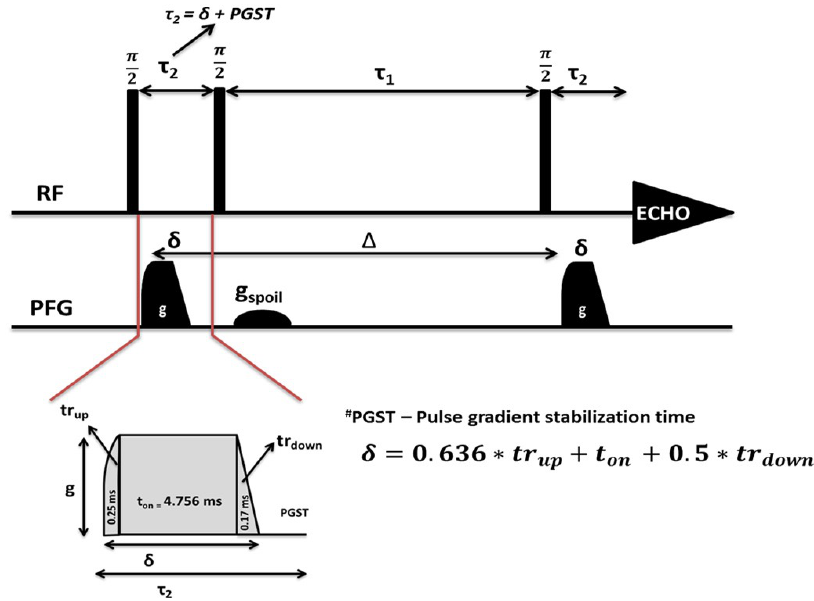
Figure 20. PFG stimulated echo pulse sequence, with composite gradient pulses [74] .